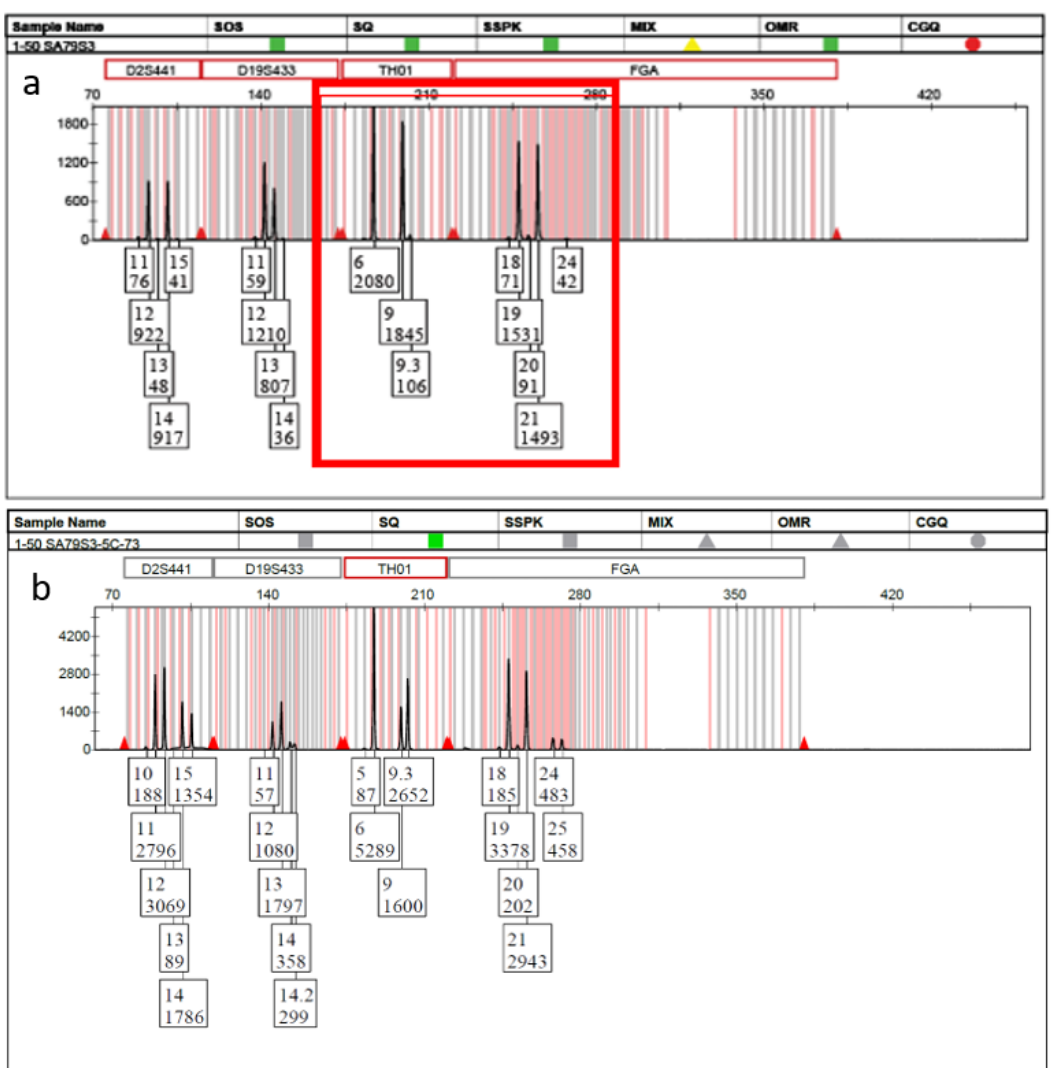
Figure 2. Undetectable/unresolvable minor donor analysis. ( a ) Standard “bulk” approach in which the only indication of a possible minor contributor is the 9.3 and 24 alleles (red box) and ( b ) 5-cell mini-mixture obtained by DSCS indicating the clear presence of a mixture.